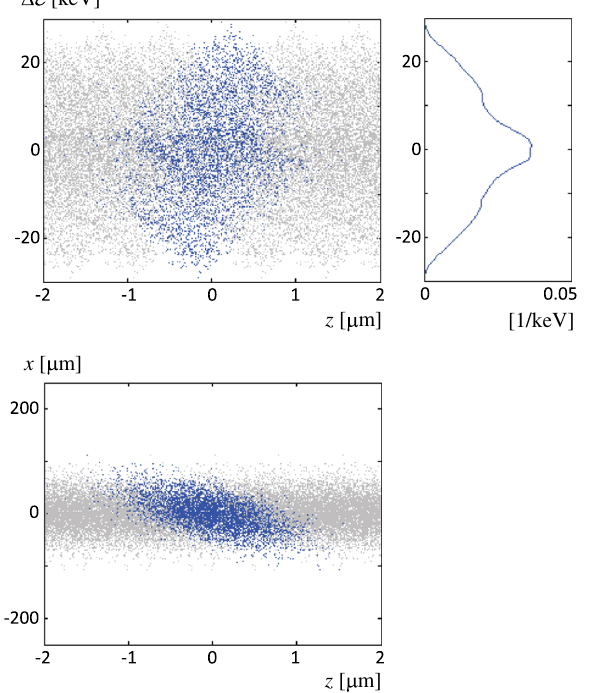
FIG. 21. Application C: longitudinal phase space ð Δ E ; z Þ , top view ð x; z Þ and energy spectrum for the position 17.5 m.